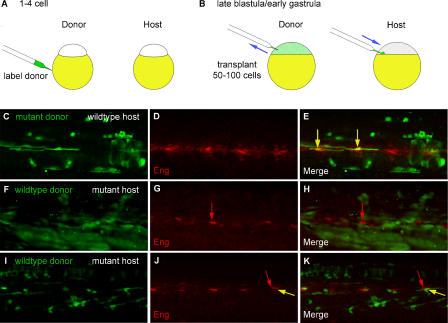

you Acts Non-Autonomously in Muscle Pioneers and Is Not Required in Cells Producing Hedgehog Signals(A) Donor embryos were labeled at the 1–4-cell stage with Oregon Green dextran.(B) Cells from donor embryos were transplanted into unlabeled hosts during late blastula and early gastrula stages.(C–E) Images from a chimera made by transplanting cells from labeled mutant donors (green in C and E) into unlabeled wild-type hosts. At 24 hpf, muscle pioneer cells in chimeric embryos were labeled with anti-Engrailed antibody (red in D and E). When transplanted into wild-type embryos, mutant cells were able to differentiate as muscle pioneers, as shown by co-labeling with the anti-Engrailed antibody (E, yellow arrows).(F–K) Images from chimeras made by transplanting cells from labeled wild-type donors (green in F, H, I, and K) into unlabeled mutant hosts. Expression of Engrailed (red in G, H, J, and K) in some mutant muscle pioneers (one marked by red arrows in G, H, J, and K) was rescued in a subset of embryos (see also Table 1). Donor cells in the embryo shown in (F–H) contributed solely to muscle and to non-floor-plate identities within the neural tube. Moreover, in a subset of chimeras, cells derived from wild-type donors differentiated as muscle pioneer cells (yellow arrows in J and K), simultaneously showing both the characteristic strong nuclear Engrailed expression and the typical flattened and mononucleate morphology of this cell type. The somite labeled with the arrows in J and K contains two muscle pioneers, one derived from the wild-type donor (yellow arrow) and another derived from the mutant host (red arrow). Donor cells in the embryo shown in (I–K) contributed primarily to muscle and to non-floor-plate identities within the neural tube; in addition, a group of seven floor plate cells derived from the wild-type donor was present in the tail of this embryo (not shown).